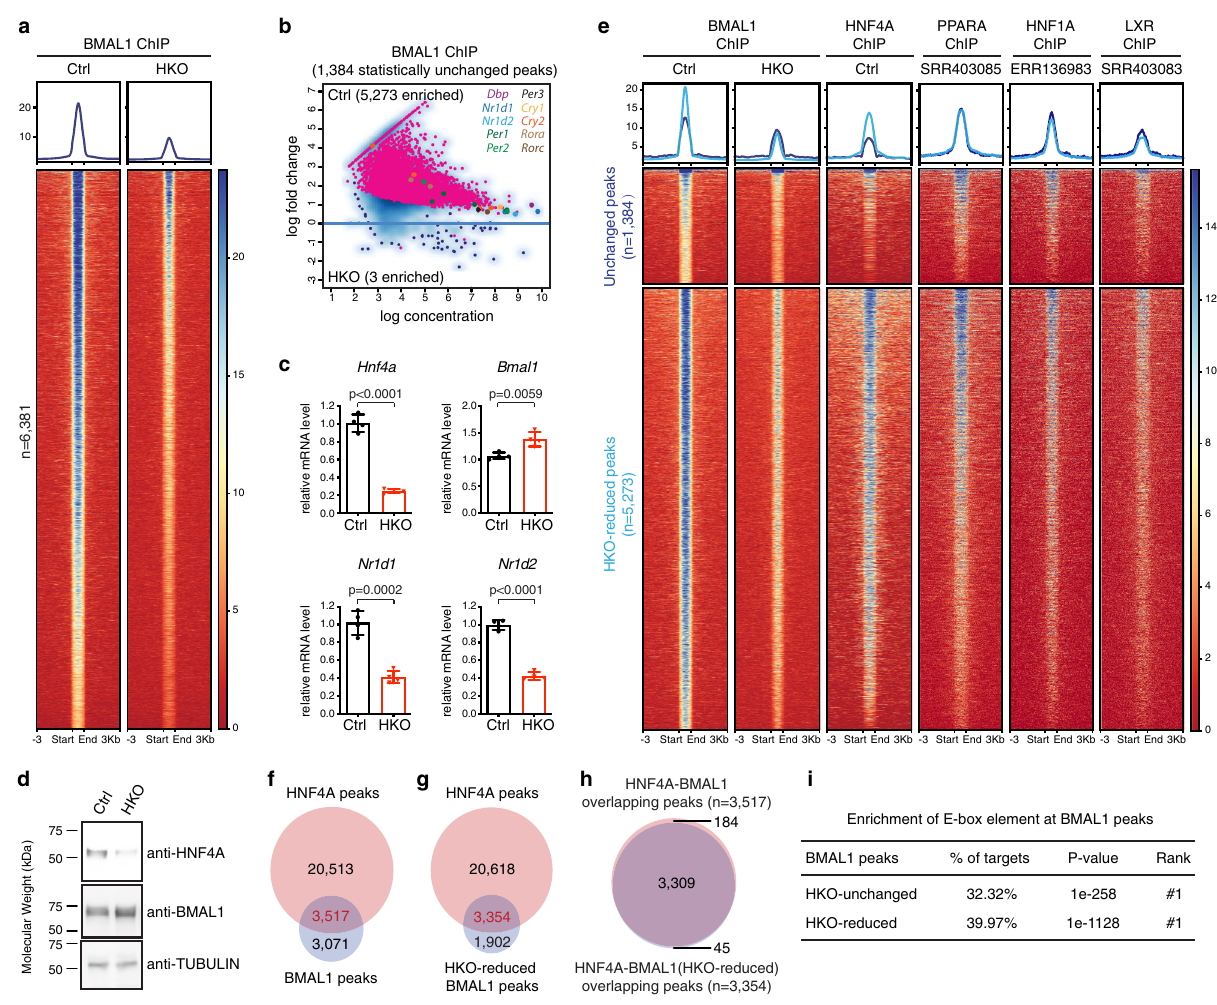
Fig. 1 BMAL1 chromatin binding is attenuated in the Hnf4a knockout liver. a Heatmap of BMAL1 ChIP-seq signals at ZT6 in control (left) or HKO (right) liver centered at all BMAL1 peaks in control liver. Peaks are ordered vertically by signal strength. b MA plot showing differential BMAL1 occupancy in control and HKO livers, using a threshold of FDR < 0.05. The x -axis represents the mean number of reads (log scaled) within the peaks across all samples. The y -axis represents the log fold change between the two samples. BMAL1 bindings at the core clock genes are highlighted. c Transcript level of genes was determined by RT-qPCR using liver samples isolated from control or HKO mice at ZT6. Displayed are the means ± SD ( n = 4) normalized to Rplp0 expression levels. Statistical signi fi cance was determined by a two-tailed Student ’ s t -test. d Protein levels were determined by western blot analysis using liver samples isolated from control or HKO mice at ZT6. Two independent experiments were repeated with similar results. e BMAL1 peaks in control and HKO livers were partitioned into three categories with DiffBind (the HKO-enriched group has only three peaks and could not be plotted), and then the corresponding TF occupancy at each BMAL1 binding site was plotted. Each horizontal line represents a single BMAL1 binding site. Peaks were ordered vertically by the strength of the BMAL1 ChIP signal in the control liver. f Venn diagram showing the overlap between all BMAL1 binding sites (at ZT6) and all HNF4A binding sites (at ZT16). Overlapping peaks were identi fi ed using the mergePeaks command in HOMER (see the “ Methods ” section). Note that the peak numbers may not add up exactly since the function automatically resolves redundant overlaps by dropping one fragment during analysis. g Venn diagram showing the overlap between BMAL1-binding sites that were signi fi cantly reduced in HKO liver (at ZT6) and all HNF4A-binding sites (at ZT16). h Venn diagram showing the overlap between the HNF4A-BMAL1 co-occupancy sites identi fi ed in ( f ) and ( g ). i A summary of de novo motif analysis showing signi fi cance values of E-box enrichment at the HKO-unchanged or HKO-reduced BMAL1 peaks.